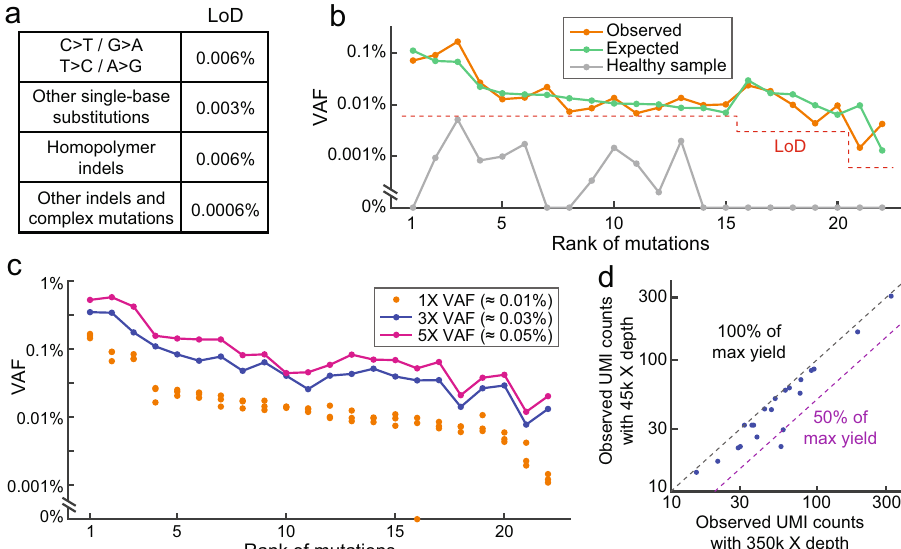
Fig. 2 Characterization of QBDA AML panel for minimal residual disease (MRD) detection. a Limit of detection (LoD) threshold for different types of mutations. b Observed mutation VAF in a spike-in positive sample and a healthy PBMC sample. The positive sample was prepared by mixing Horizon Myeloid DNA Reference Standard, 3 synthetic gBlocks, and a gDNA sample extracted from healthy PBMC, resulting in VAF between 0.001% and 0.1% for 22 different mutations. Sixteen out of 22 mutations were around 0.01% VAF (between 0.005% and 0.02%). The “ expected ” VAF was quantitated by UMI- based NGS without mutation enrichment. All 22 mutations covered by the AML panel were observed in the positive sample (orange line); 82% of the mutations were within twofold of expected VAF. The same healthy PBMC sample was also analyzed alone as the paired negative sample using the AML panel (gray line). In a healthy sample, some mutations (C > T or G > A) are observed at below-LoD level, possibly due to clonal hematopoiesis. Here 1 µ g of gDNA was used for each library. c Quantitation accuracy. The positive sample in ( b ) was sequenced in triplicate NGS libraries; two additional positive samples with threefold or fi vefold VAF of the abovementioned sample were also analyzed. For each of the 22 mutations, the observed VAF was in correct order for the 1×, 3×, and 5× VAF samples. In the triplicate experiment of the 1× VAF ( ≈ 0.01%) sample, one mutation was not observed in one of the replicates, thus the sensitivity is approximately 1 – 1/(22 × 3) = 98.5%. One micrograms of gDNA was used for each library. d Sequencing depth down to 45,000× does not affect sensitivity in 1X VAF ( ≈ 0.01%) sample. The 1× VAF positive sample (500 ng input) was sequenced with 350,000× depth (7.7 M reads). Even after downsampling to 45,000× depth sequencing by random sampling 1.0 M reads from the original library, all mutations are observed. The median observed UMI counts from 20 independent simulations were plotted against observed UMI counts in the original